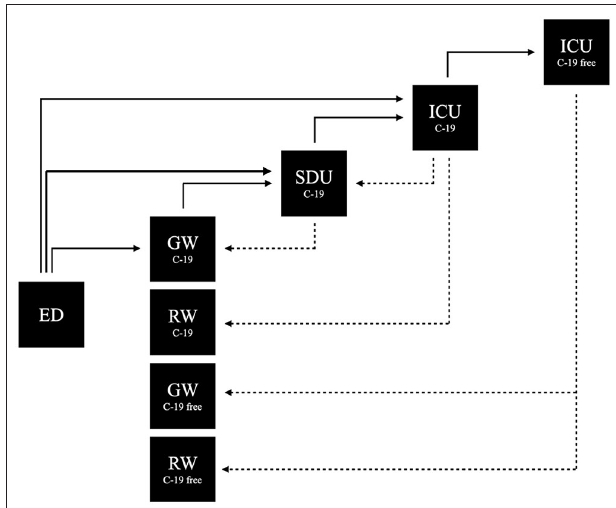
FIGURE 2 | Patient COVID-19 flow. Patients flow between the different units during the pandemic peak. For the number of patients refere to Table 2 .